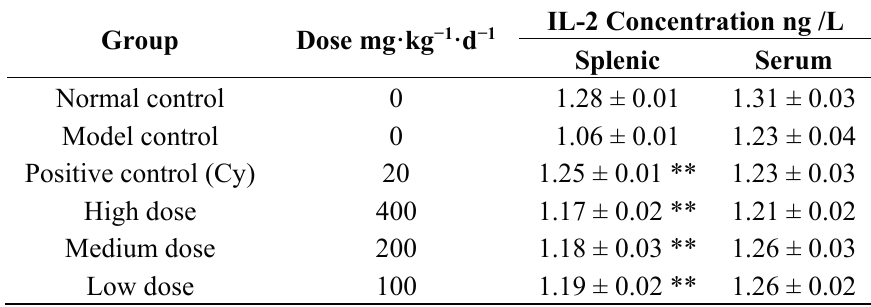
Table 5. Effects of BBP3-1 on immune factors IL-2 in lymphocytes ( x ± s, n = 10).